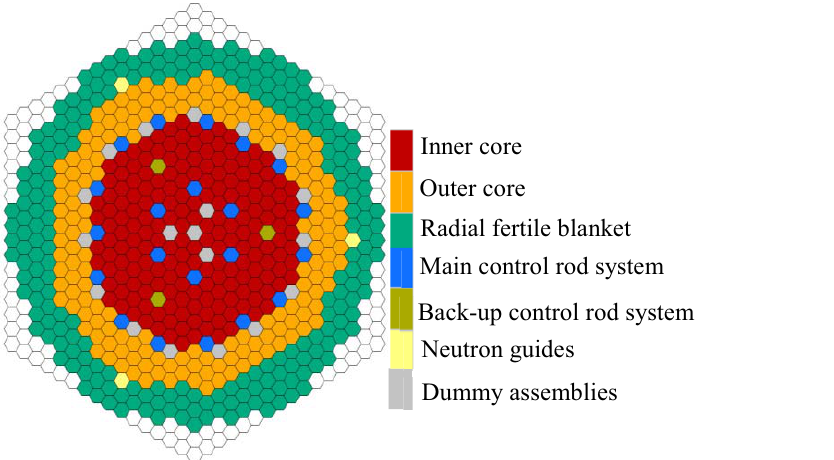
Figure 1. Superphénix start - up core layout